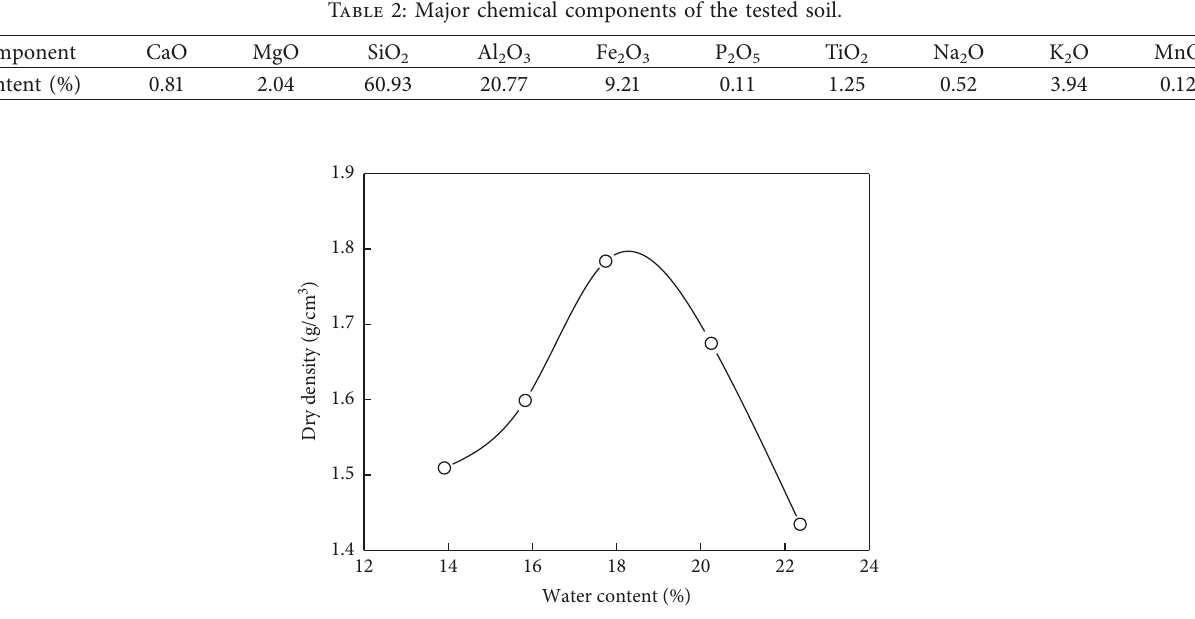
Figure 1: Compaction curve of the tested soil. Table 3: Major chemical components of the alkaline residue.